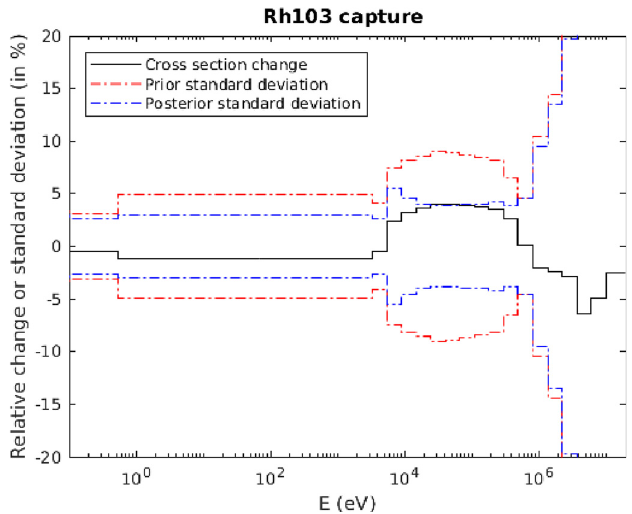
Fig. 8. Multigroup trends and associated uncertainties, by the assimilation of the MAESTRO+ ERMINE experiments together, with the removal of indirect sensitivity